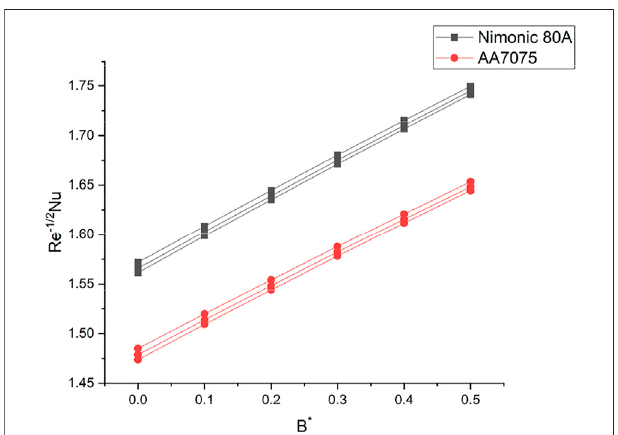
FIGURE 9 | Change in Re − 1/2 C f for ϕ versus Γ 1 .